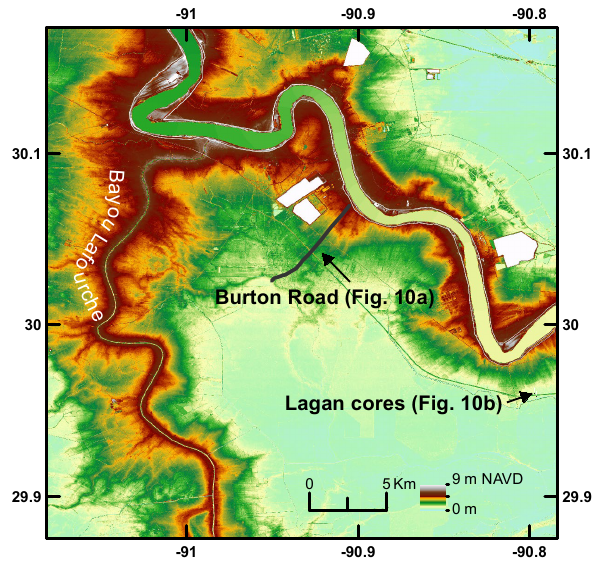
Figure 9. Digital elevation map (NED 1/3arcsec) of the modern Mississippi River downstream of the Bayou Lafourche bifurcation (for location see Fig. 1b) with the location of cross section Burton Road and the Lagan cores (Fig.